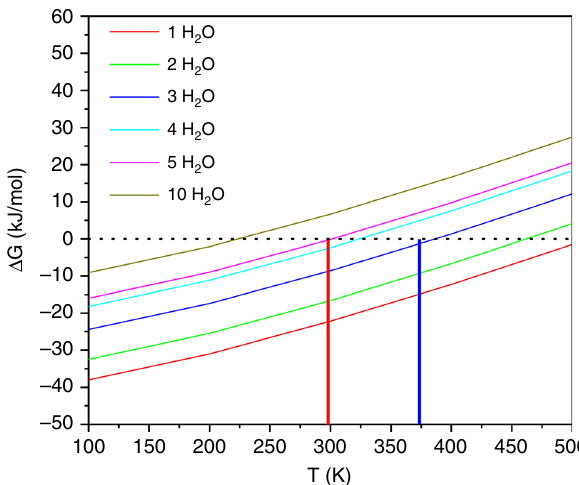
Fig. 4 Calculated Gibbs free adsorption energies as a function of temperature. The 6 thin solid curves describe scenarios with different number of H 2 O molecules (1 – 10) in the vicinity of a Brønsted acid site. The dashed horizontal line represents Gibbs free energy at zero, and the vertical red and blue lines correspond to 298 K and 373 K,